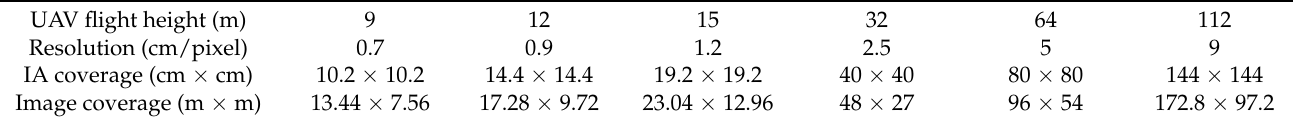
Table 1. The ground sampling distance in each of the acquired image sequences.